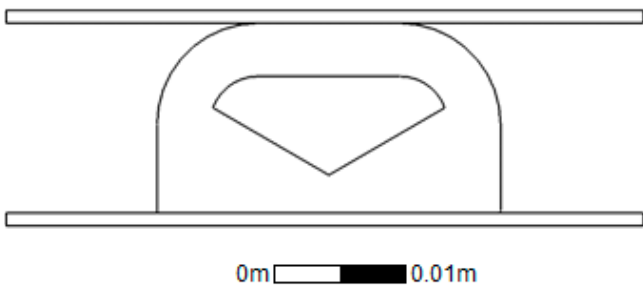
Figure 14. Profile of the D-Shaped EPDM Gasket.